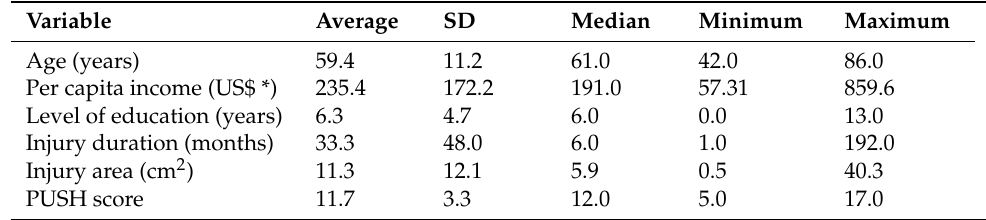
Table 1. Baseline characteristics of the patients and their venous ulcers.